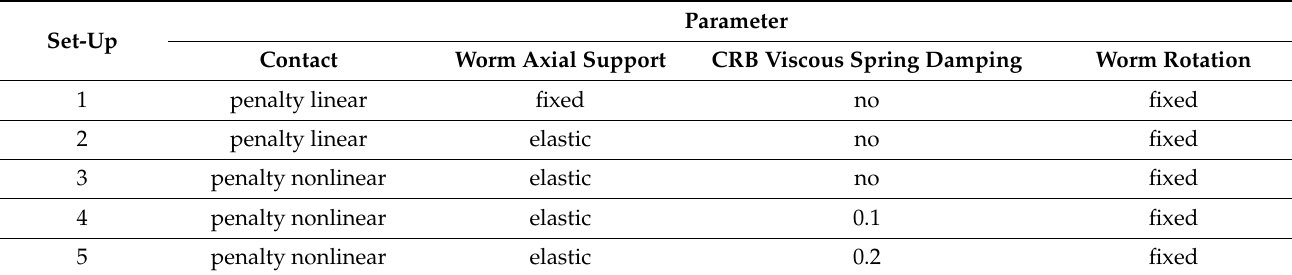
Table 3. Undamped contact simulation set-up.